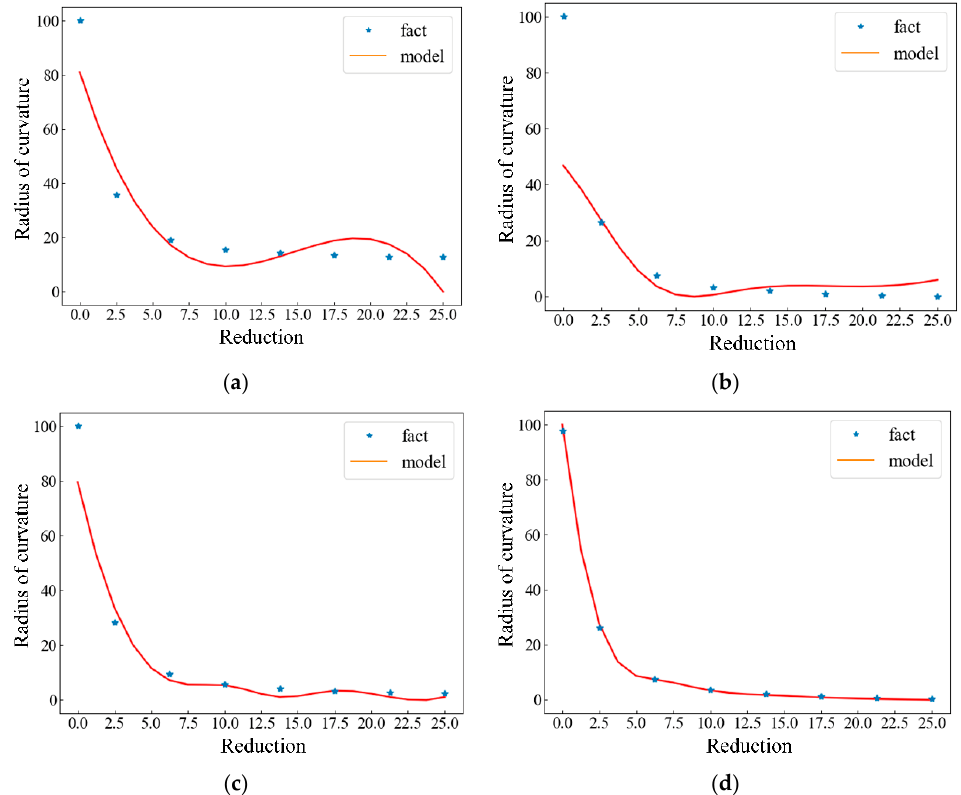
Figure 11. Model Fit Comparison Chart. ( a ) Polynomial regression; ( b ) SVR; ( c ) neural networks; ( d ) XGBoost + Bayes.